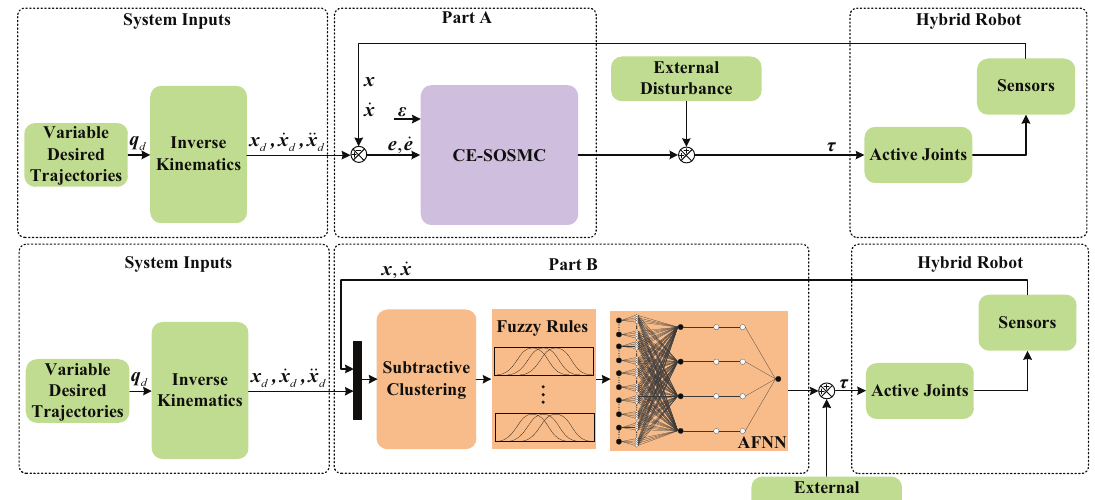
Figure 2. The control schematic